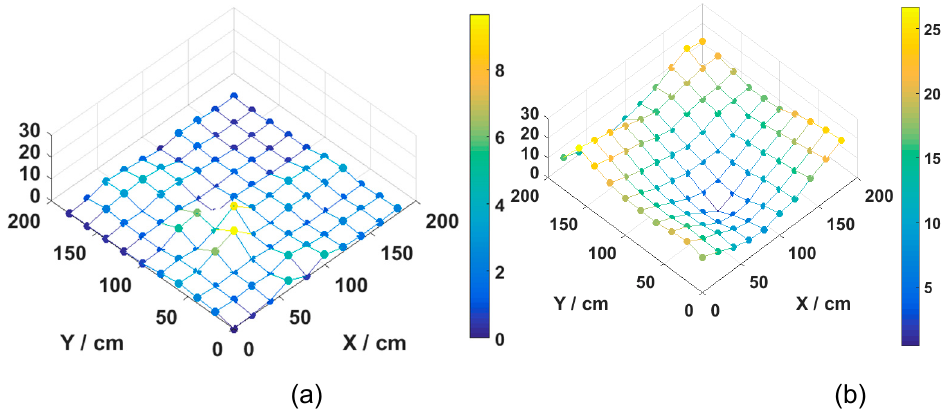
Figure 8. Distribution of positioning error for ( a ) MMBP algorithm with even training data set and ( b ) traditional received signal strength (RSS)-based algorithm. Sensors 2019 , 19 , x FOR PEER REVIEW